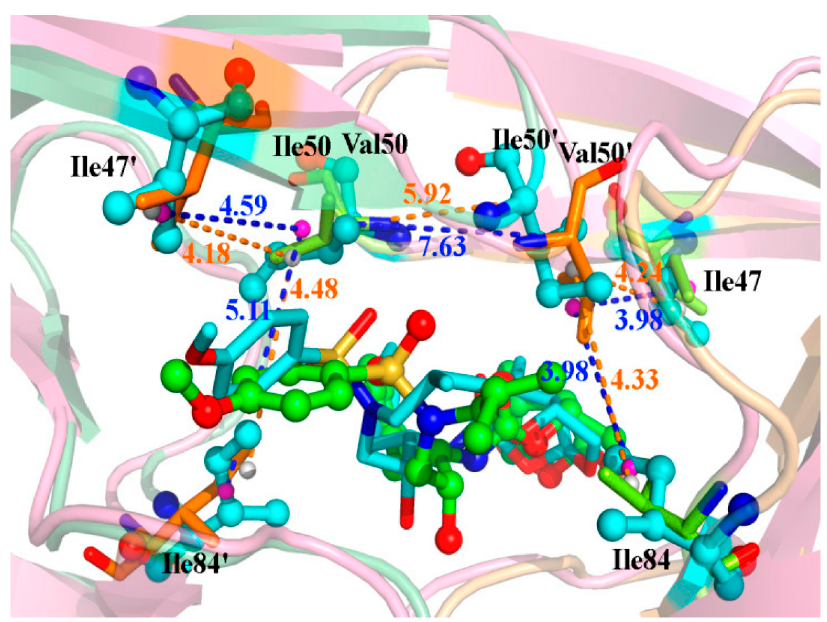
Figure 6. The key residues of the I50V complex, superimposed on those of the WT complex. The averaged distances are shown with dashed lines in blue (I50V) and orange (WT). The representation is the same as in Figure 5.